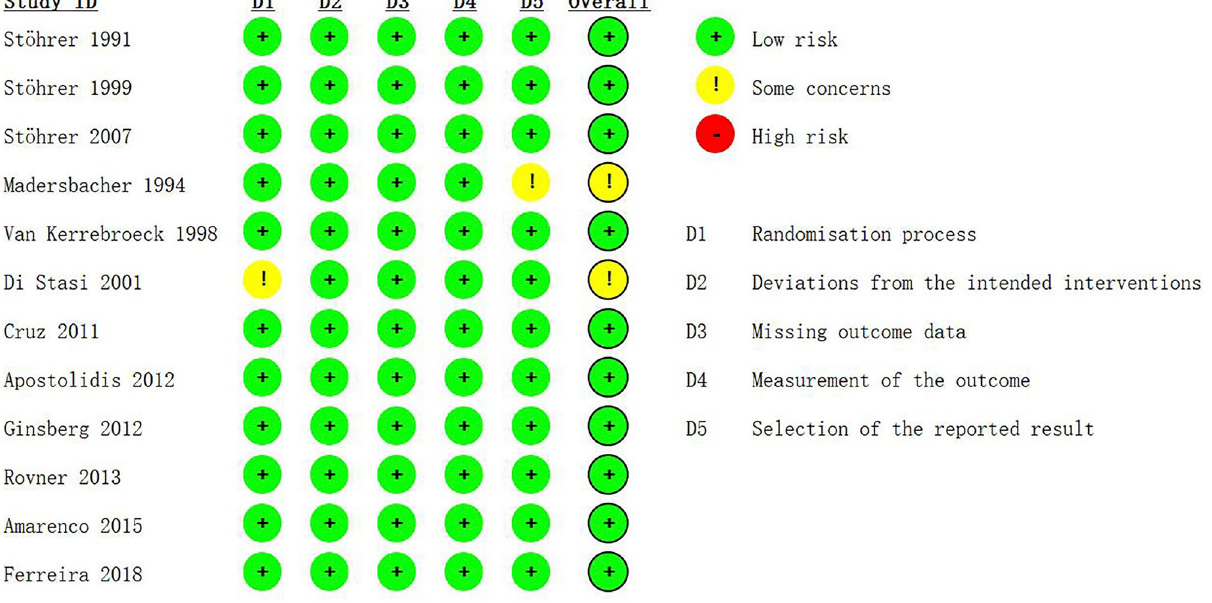
Figure 3. Risk of bias figure using ROB 2 tool. D1: Randomisation process; D2: deviations from the intended interventions; D3: missing outcome data; D4: measurement of outcome; D5: selection of the reported result. Low risk, (cid:4)(cid:4) Some concerns, High